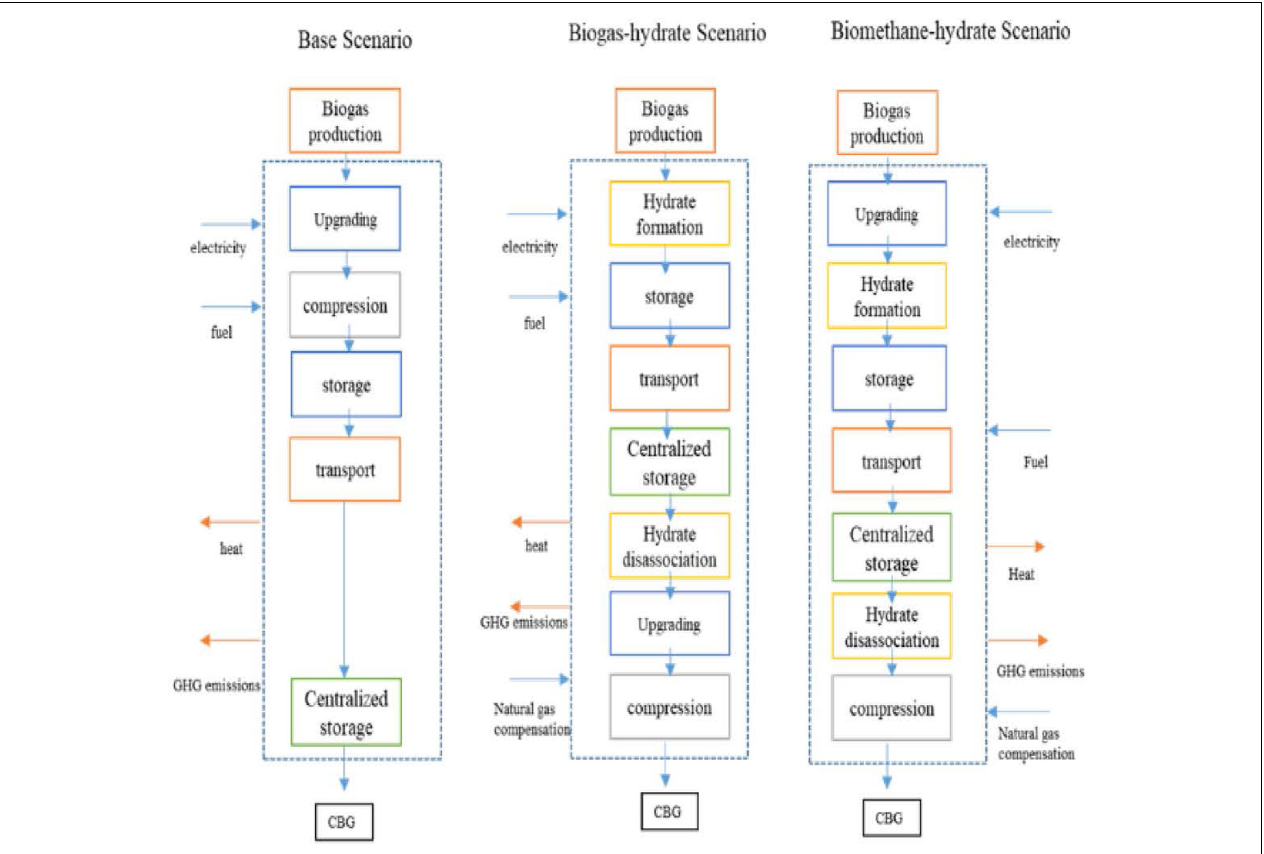
FIGURE 1 | Flow chart and system boundaries of the three scenarios